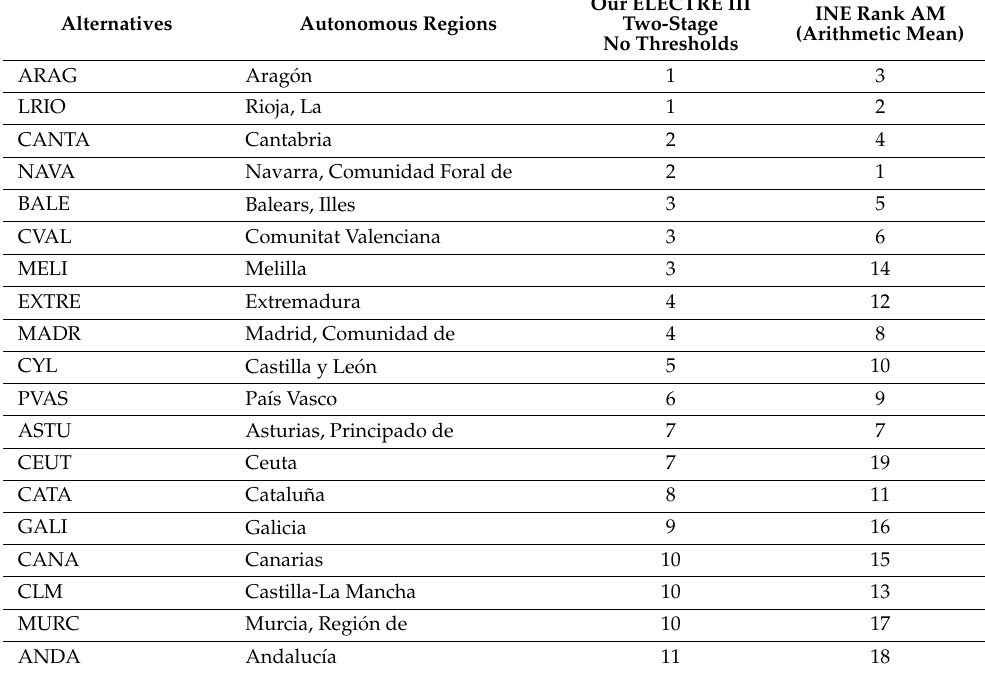
Table 8. The indifference and preference thresholds for each one of the indicators of the 9 dimensions.